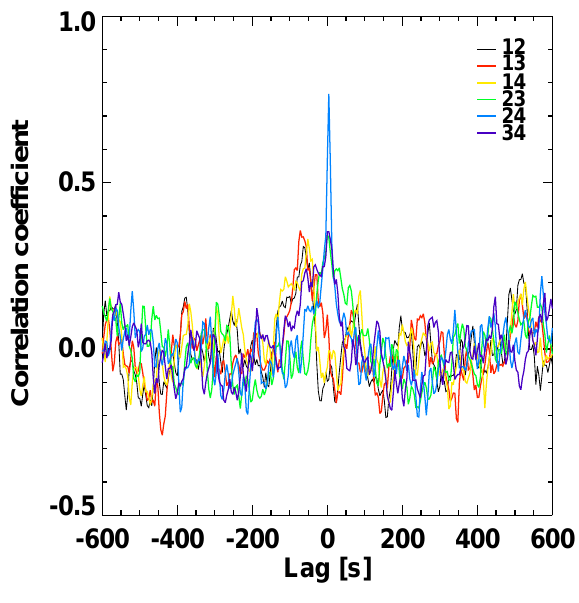
Fig. 3. An example of cross-correlation functions computed be- tween Cluster spacecraft pairs (denoted different colors) between 13:00 and 14:00UT, 12 December 2002 (only ± 600s of the lag range is shown).